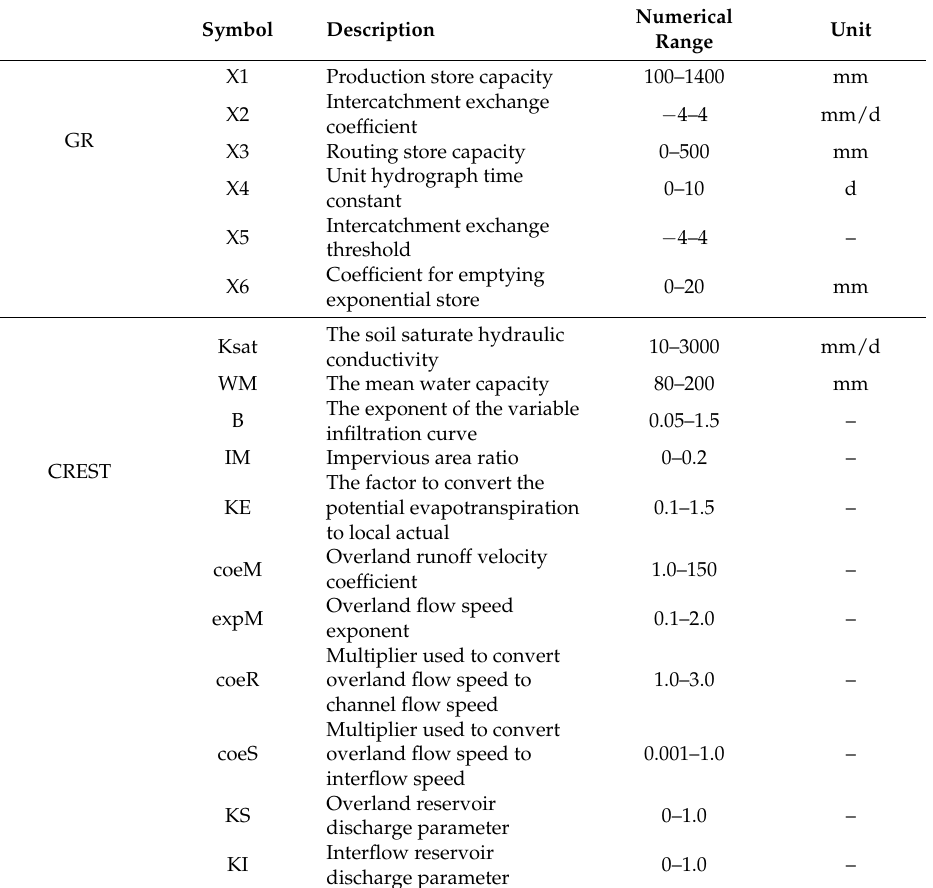
Table 1. Summary of parameter information for the G é nie Rural (GR) and Coupled Routing and Excess STorage (CREST)